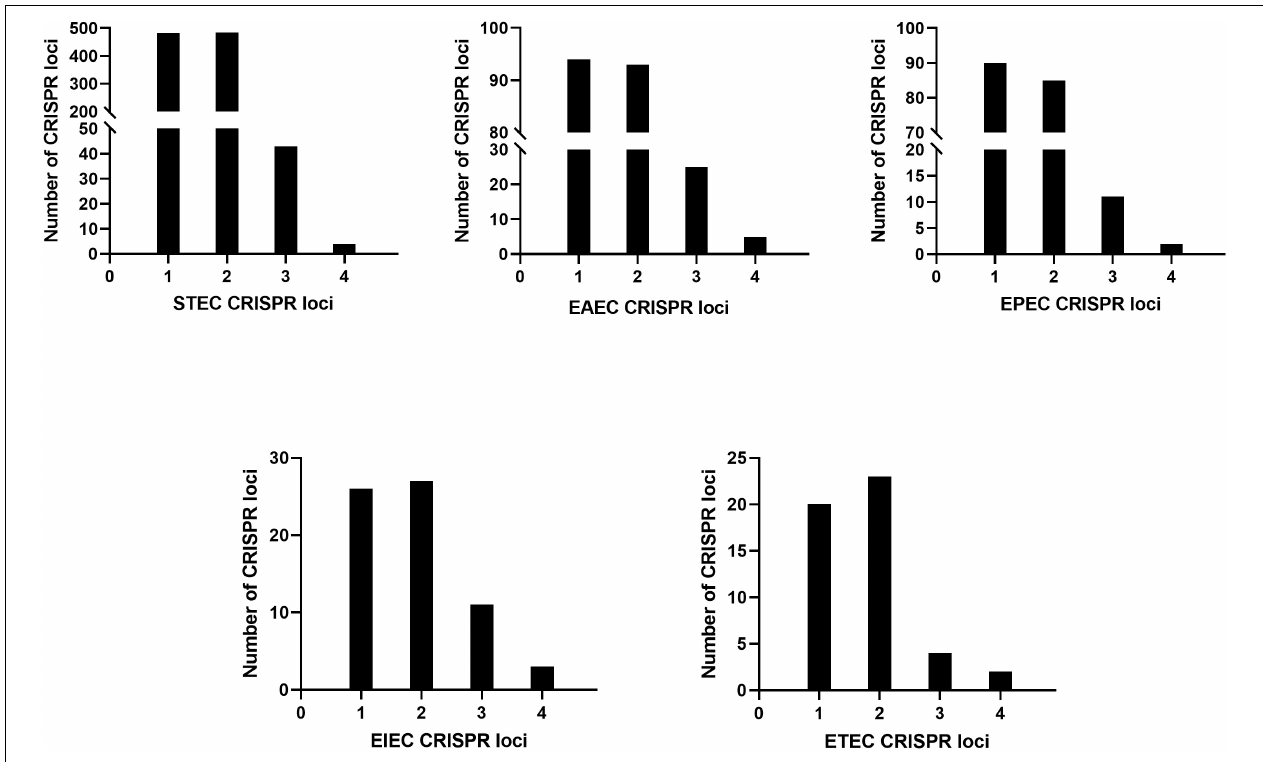
FIGURE 1 | Number of DEC CRISPR